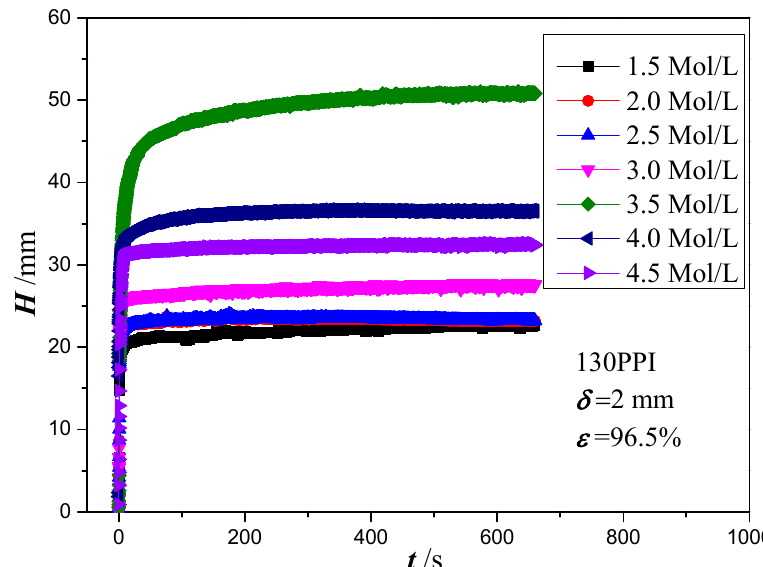
Figure 5. Wicking height versus time for different NaOH and NaClO 2 solution concentrations.